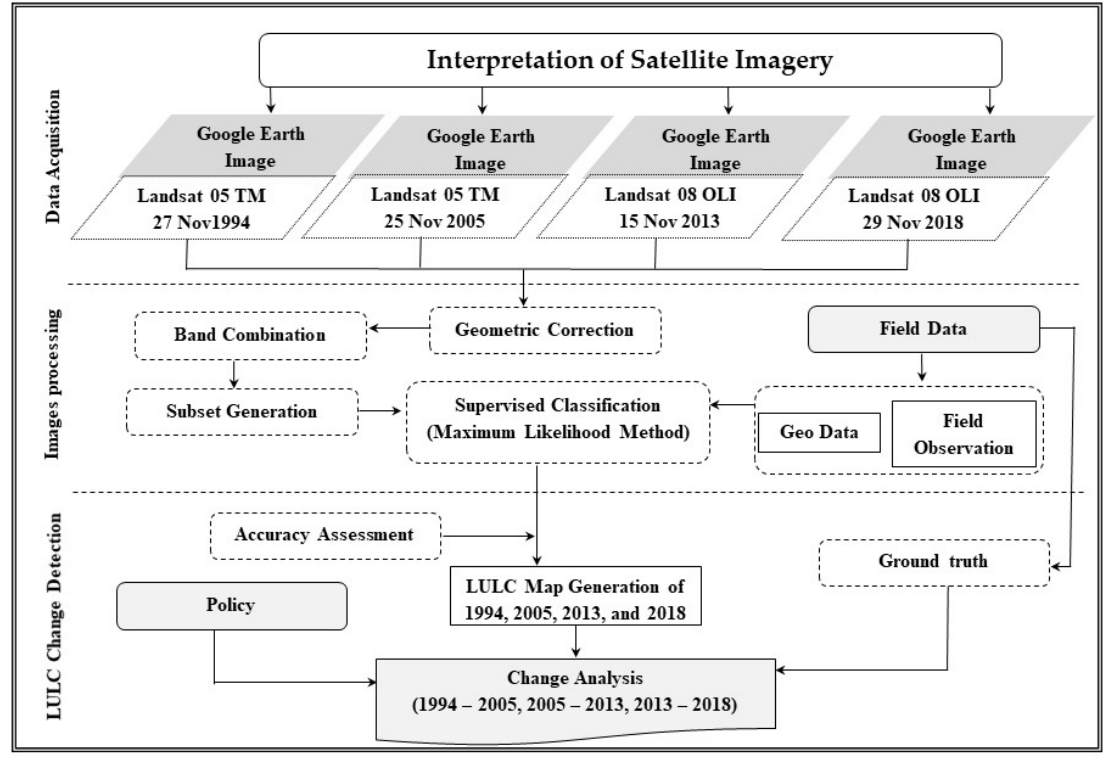
Figure 3. General methodological flowcharts: data acquisition, land use and land cover (LULC) analysis, and trends in forest land use changes in RKWS, Bangladesh.